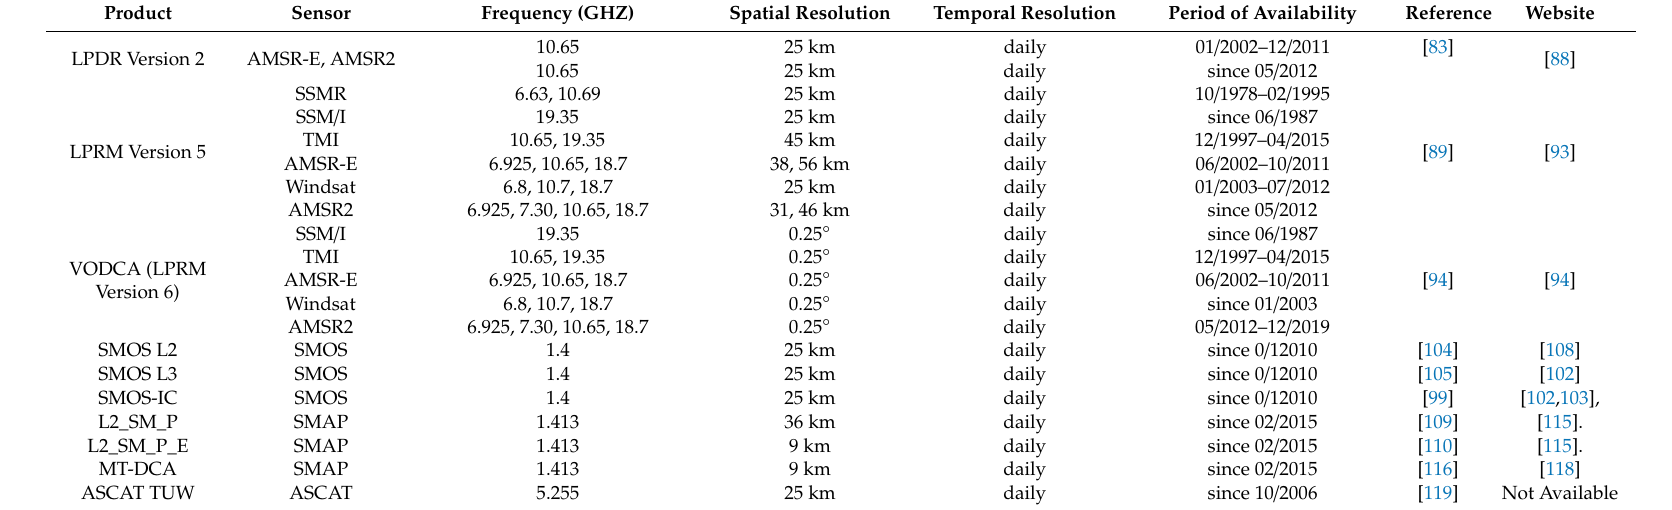
Table 2. Characteristics of the global long-term VOD products.